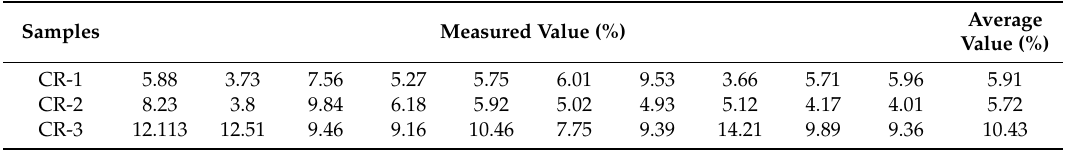
Table 2. The results of volume of CR particle in AR binders.